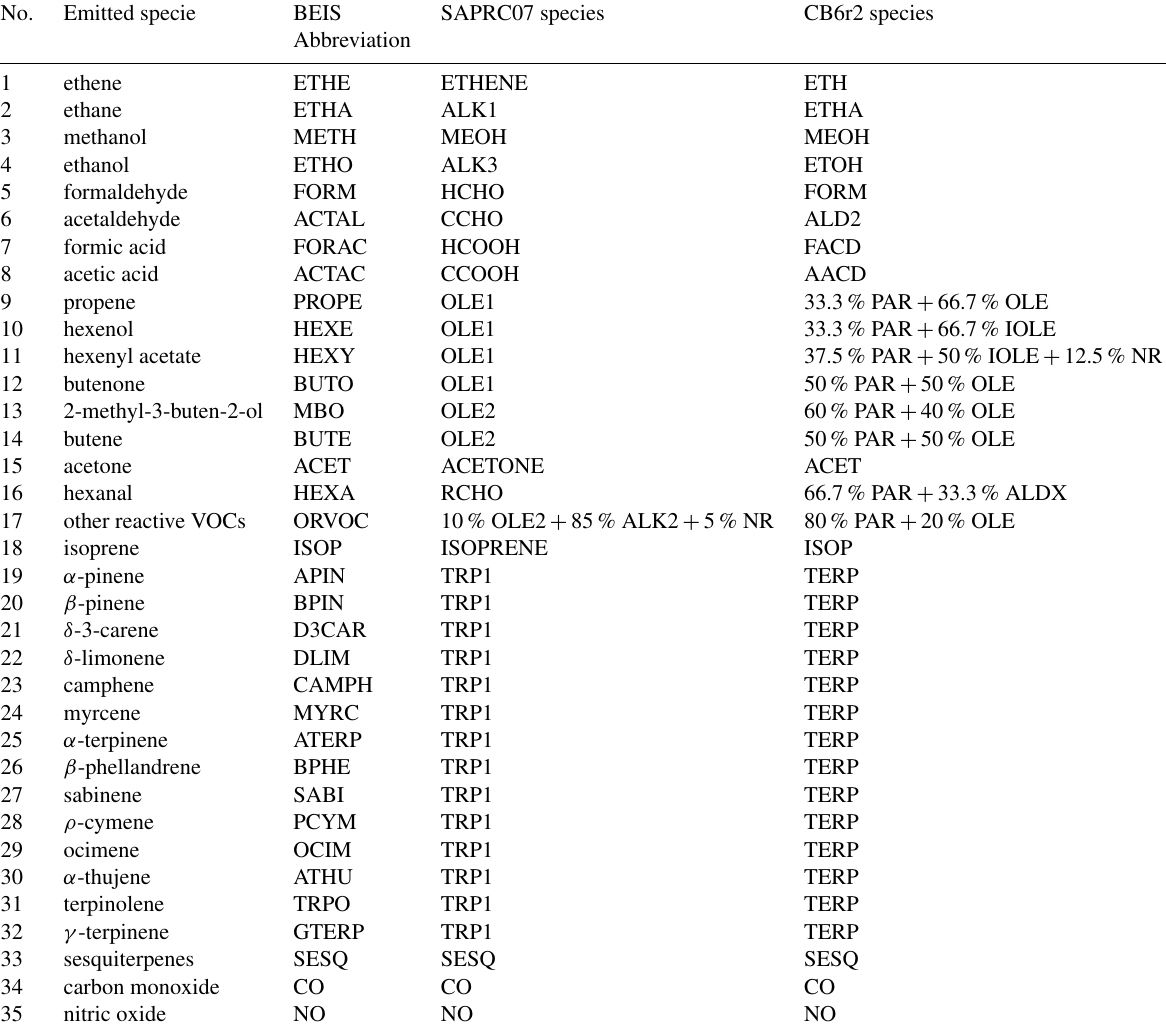
Table 1. Species emissions estimated by BEIS and mapping to the SAPRC07T and CB6r2 gas-phase chemical mechanism lumped species.